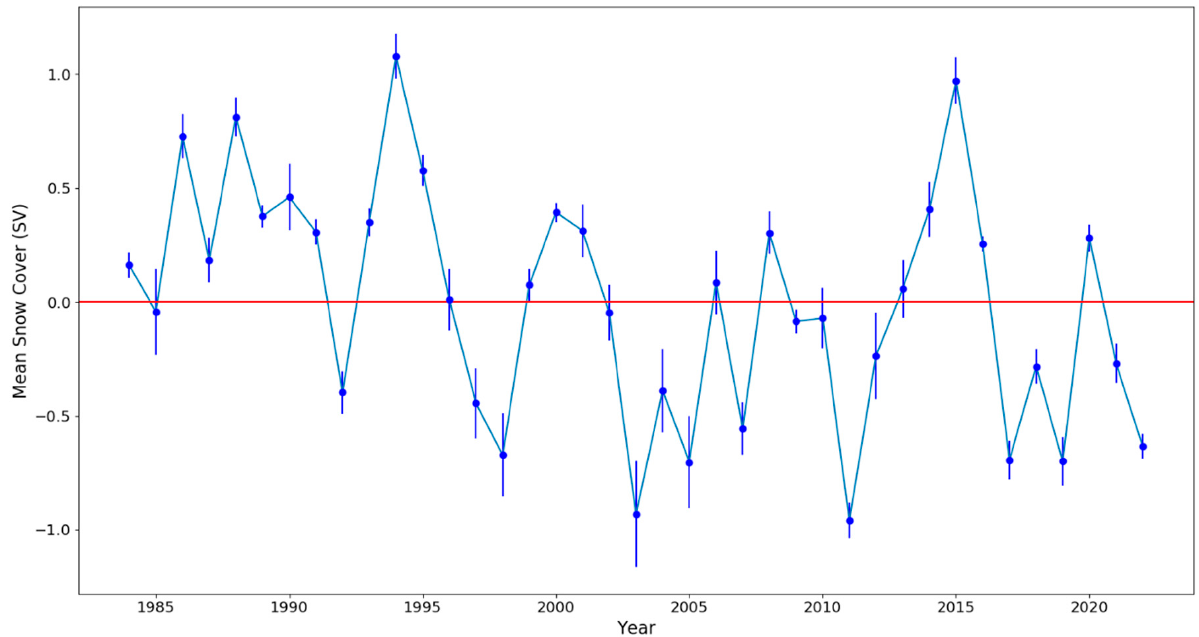
Figure 5. Mean annual snow cover from 1984 to 2022. Error bars show standard error. Positive values of SV indicate more snow than normal, negative values indicate less than normal.